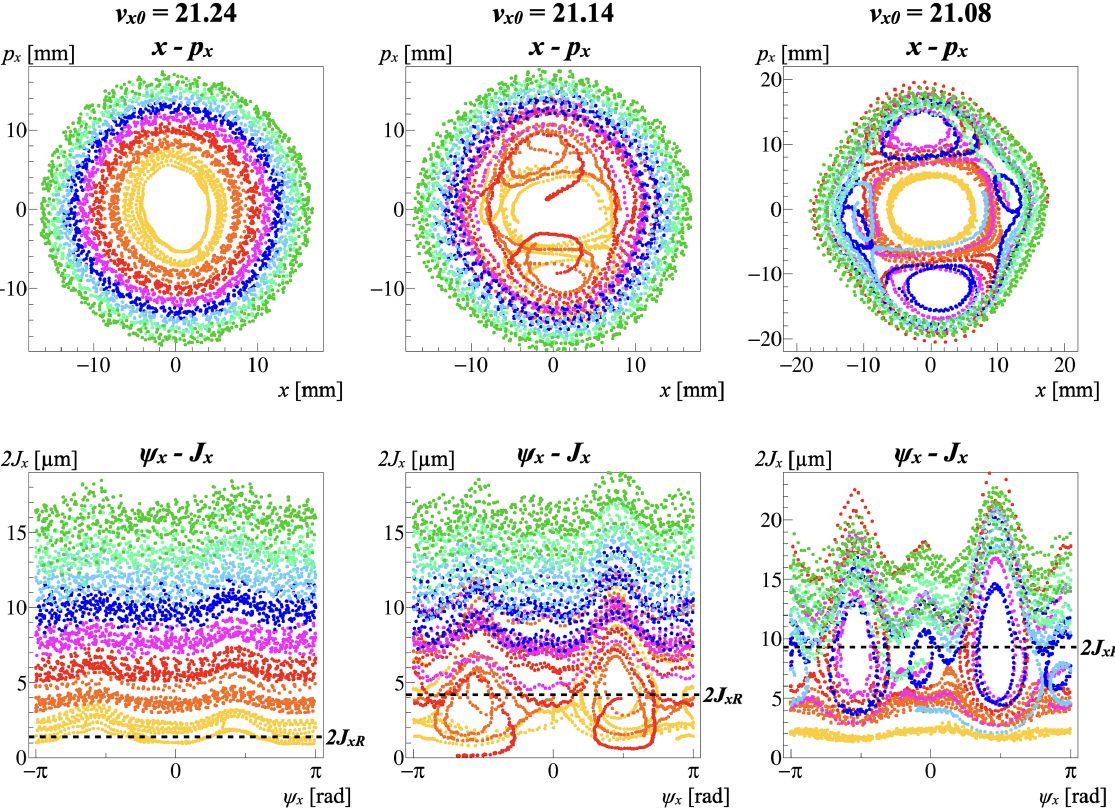
FIG. 9. Poincar´e maps obtained from SCTR calculations using the frozen model. The left panel corresponds to ν x 0 ¼ 21 . 24 , the center panel to ν x 0 ¼ 21 . 14 , and the right panel to ν x 0 ¼ 21 . 08 . The top row shows the Poincar´e maps of the normalized phase-space coordinates and the bottom row shows those of the action-angle coordinates. The same colors represent the same action in all plots. The black dotted lines in the bottom row figures represent the actions which meet the resonance conditions calculated analytically.